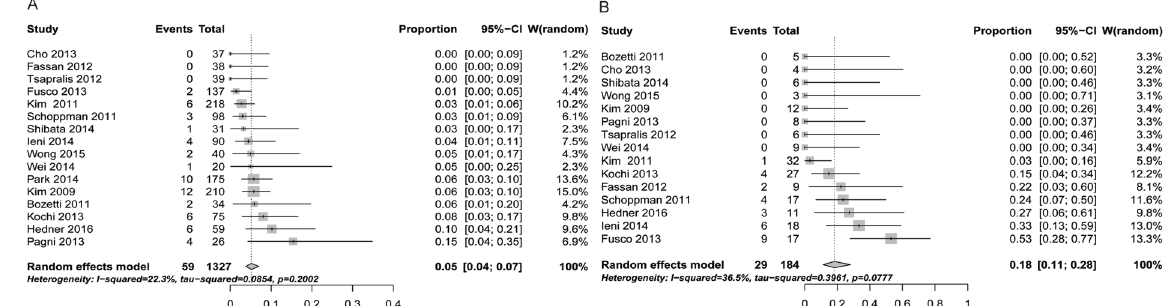
Figure 5. Random-effect single-arm meta-analysis of ( A ). Proportions of positive to negative discordant HER2 status in gastro-esophageal adenocarcinomas ( B ). Proportions of negative to positive discordant HER2 status in gastro-esophageal